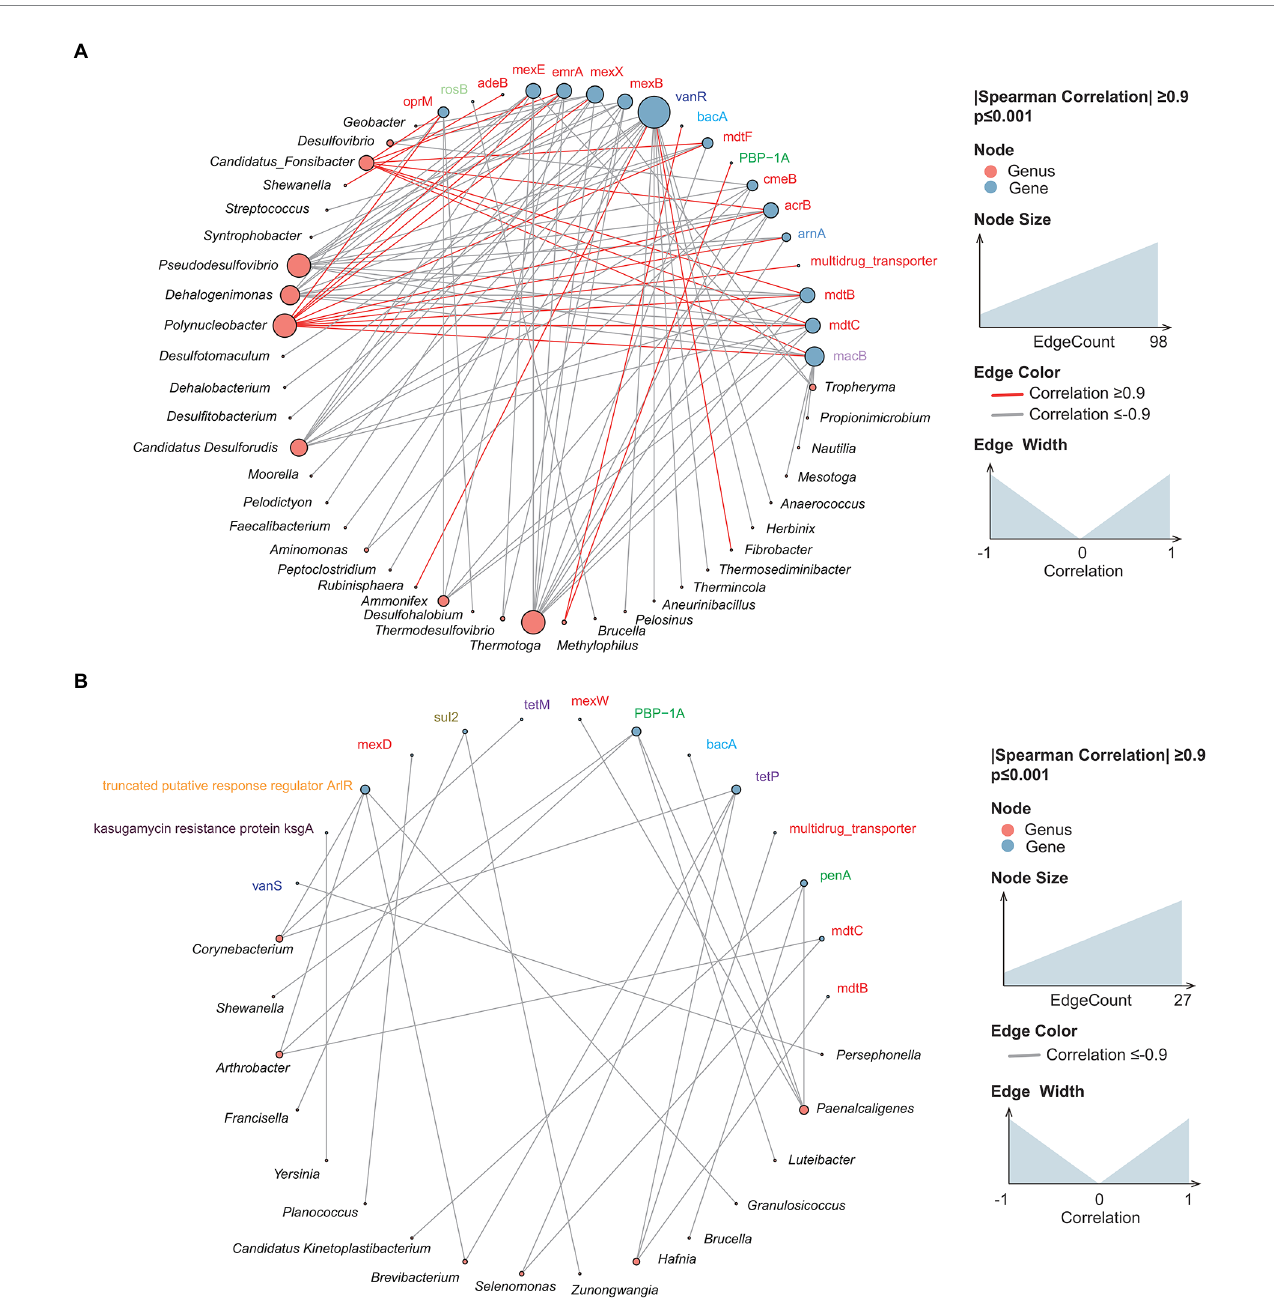
FIGURE 8 Cross-genus co-occurrence network of ARGs in samples. Network analysis coloring based on taxonomic genus preference. Associations indicated a significant ( p < 0.001), scored as positive (spearman’s p > 0.9 or p < − 0.9). The size of each node is proportional to the SAV degree; the thickness of the connection between two nodes is proportional to the value of the Spearman correlation coefficient. (A) Sediment samples; (B) water